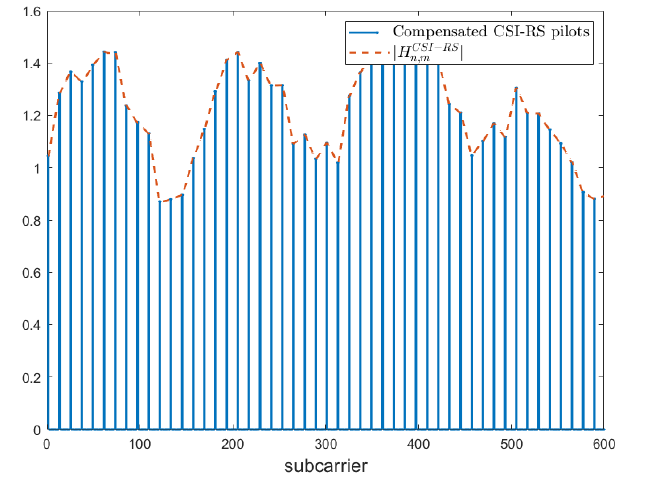
Figure 2. Module of interpolated channel matrix | H CSI-RS n , m |